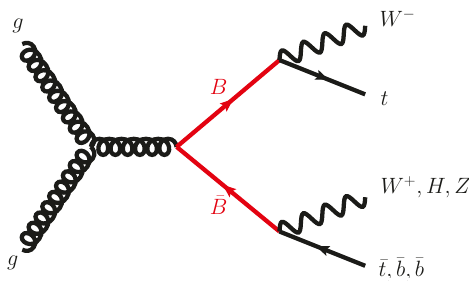
Figure 1 . Example of a leading-order B (cid:22) B production diagram in the targeted Wt decay mode. W bosons and top quarks. The decay products of a hadronically decaying high-momentum W boson are likely to be contained within a single large-radius jet. The two signal regions used in this search are based on the number of reconstructed large-radius jets. The (cid:12)rst signal region aims to reconstruct the B (cid:22) B system using the mass of the purely hadronically decaying B candidate to discriminate between SM and VLQ events. The second, more and VLQ